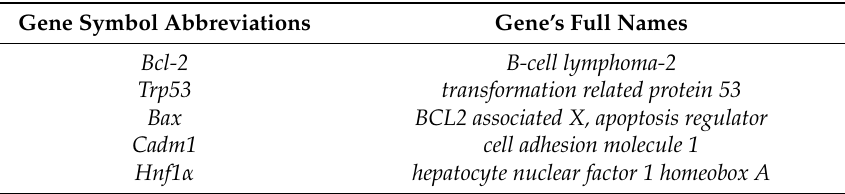
Table A1. Gene symbol abbreviations and full